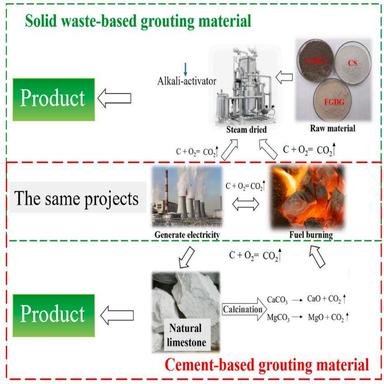
CO2 emission analysis diagram of grouting materials.